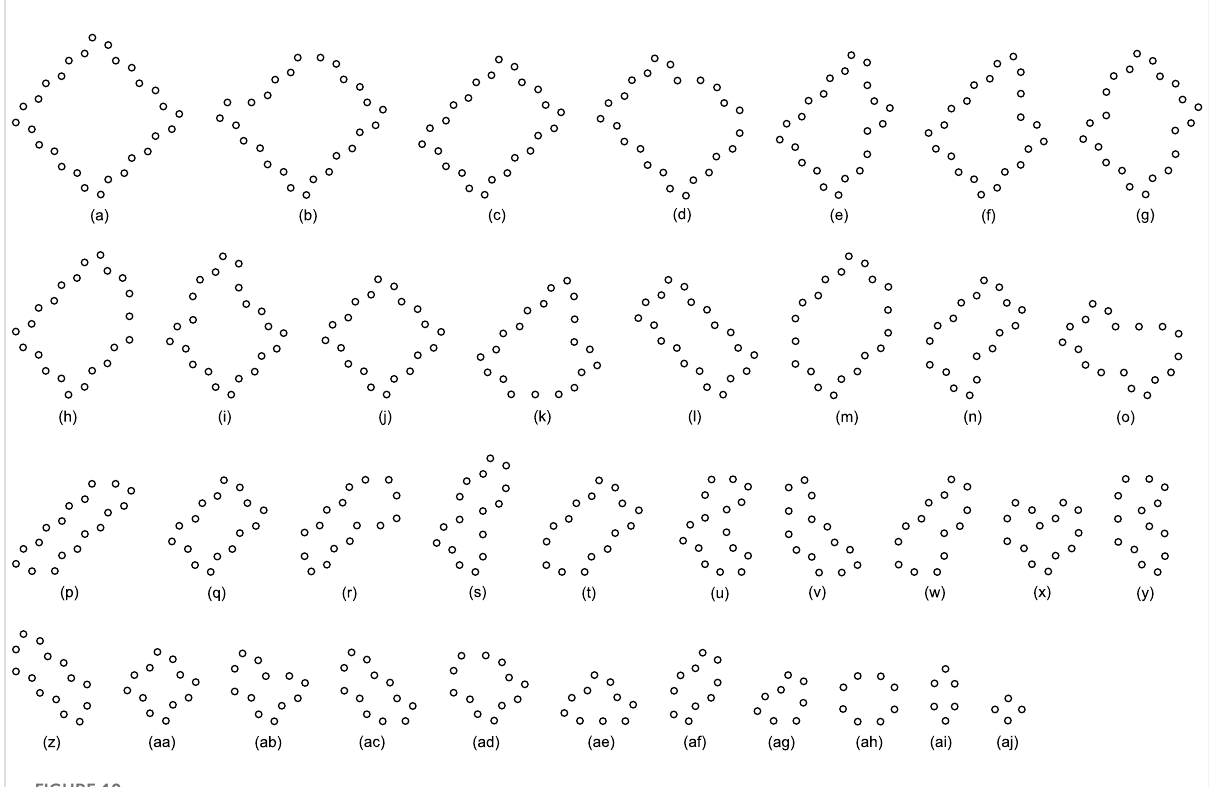
FIGURE 10 All fi nal loop structures starting from the con fi guration in Figure 7C by the greedy selection, adding, and changing